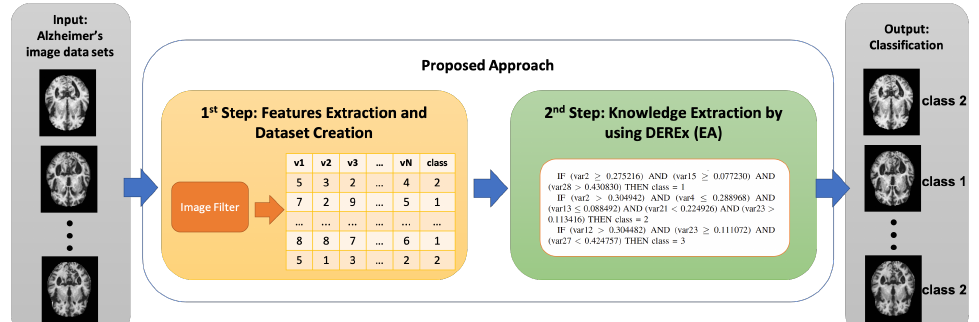
Figure 1. The approach. The left part of the image contains the filter (1st step), whereas the right part contains the classifier (2nd step) based on an Evolutionary Algorithm (EA). This latter also extracts explicit knowledge. MRI images contained in this figure are taken from the original Alzheimer’s data set [53] available on